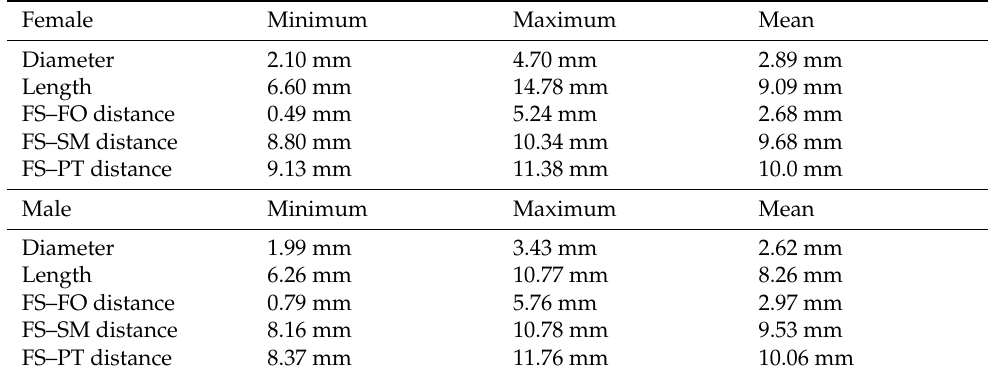
the right side. Regarding FS–FO distance, the values ranged from 0.5 to 5.76 mm (with a mean of 2.87 on the right side and 2.97 on the left side). As observed in female skulls,